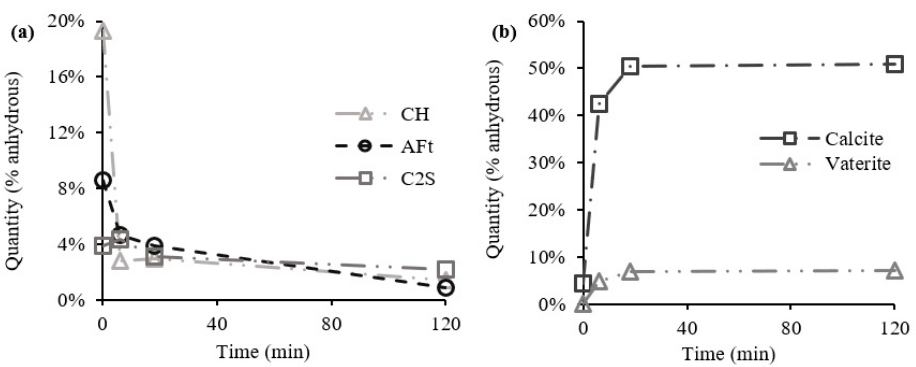
Figure 6. Crystalline phases consumed ( a ) and produced ( b ) from